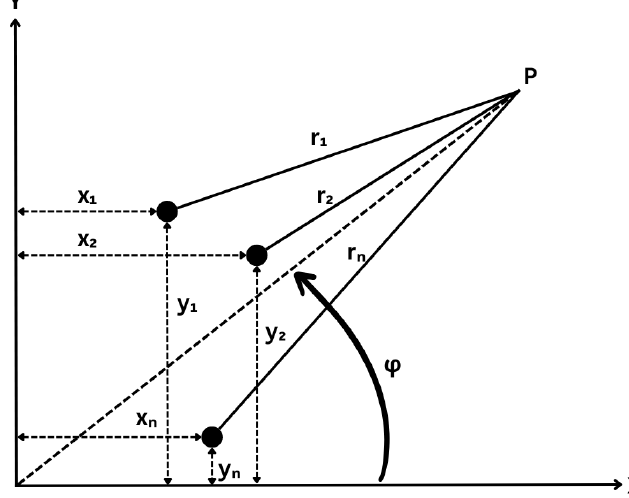
Figure 4. Schematic diagram of dipole placement in XY coordinate plane.